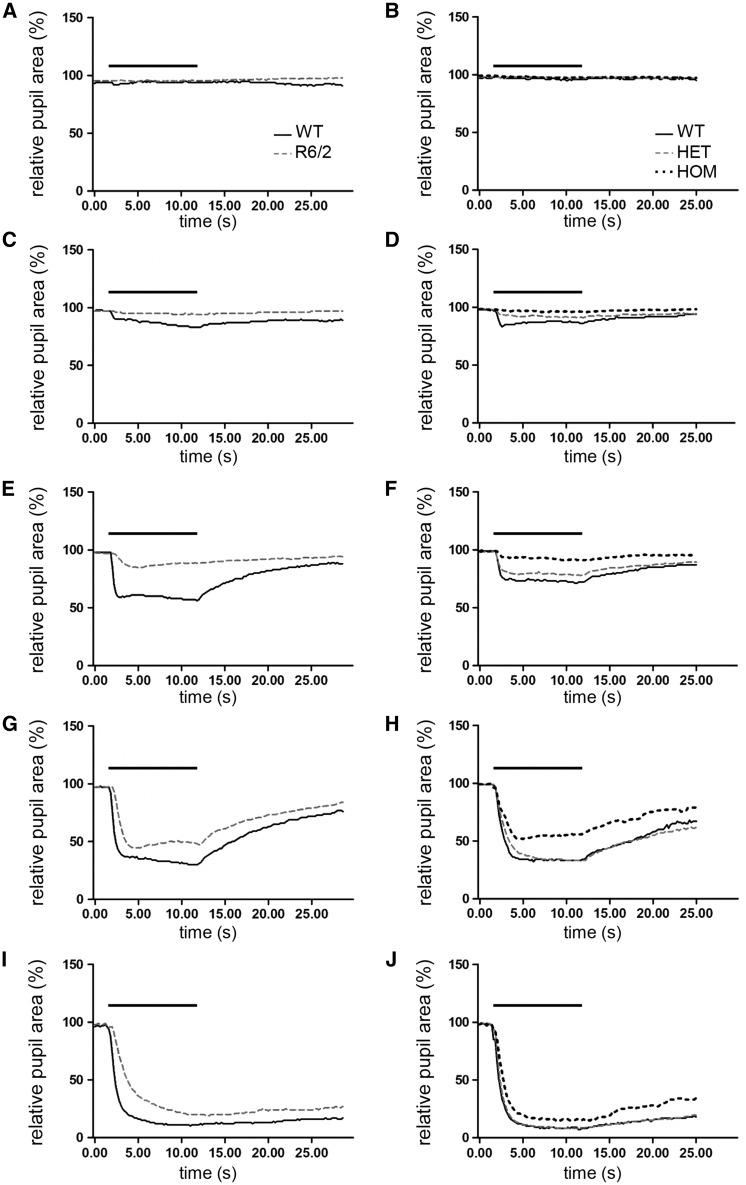
Dynamics of pupil light reflex in R6/2 and homozygous Q175 mice at late stage of lifespan. Consensual pupil constriction profiles shown are recorded from 20 week old R6/2 (A,C,E,G,I) and 20 month old Q175 homozygous (HOM) (B,D,F,H,J) mice in response to 10-s light exposure at different illumination irradiance: 9.3 (A, B), 10.5 (C, D), 11.7 (E, F), 12.9 (G, H) and 14.6 (I, J) log quanta/cm2/s. The bar above the traces indicate the duration of light stimuli (from 2 to 12 s). All data are mean of response ± SEM.